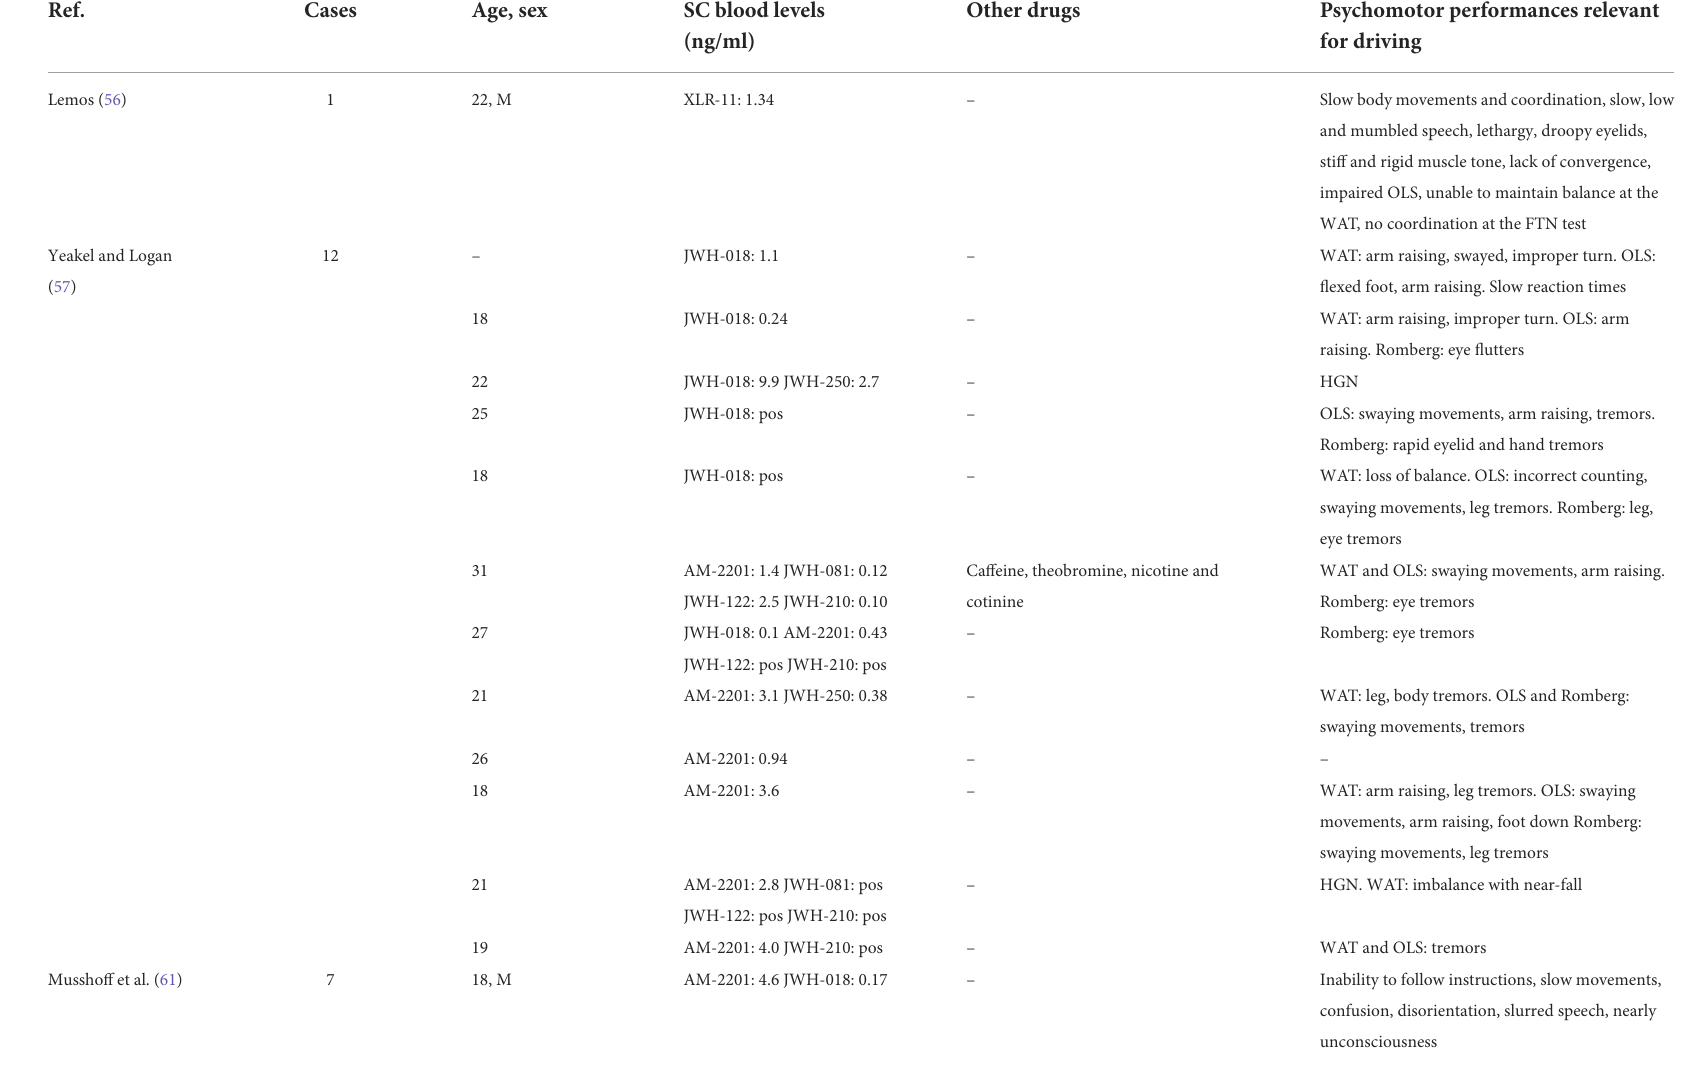
TABLE 2 Cases of DUI of SCs.